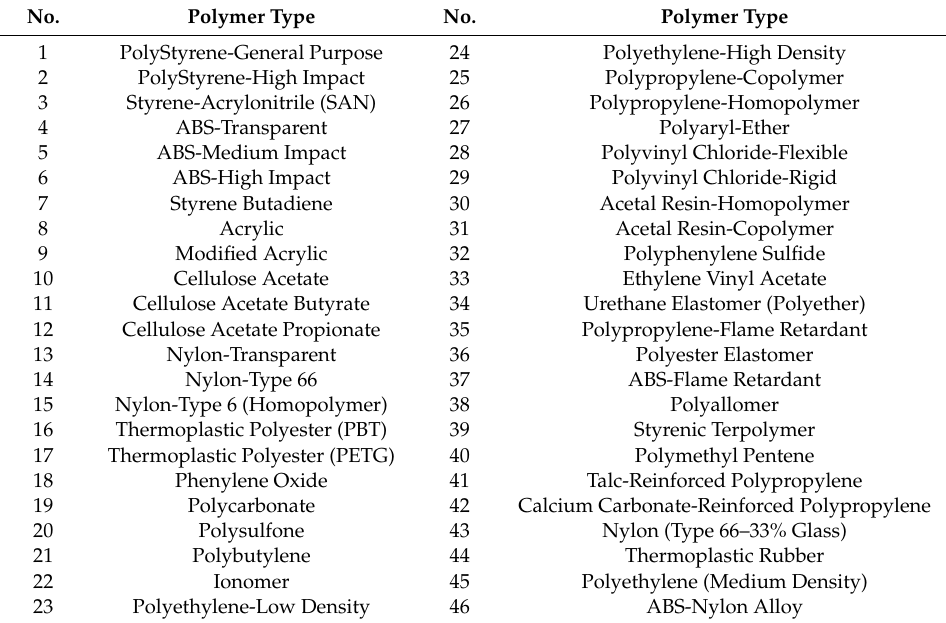
Table 6. Polymer materials used for the classification